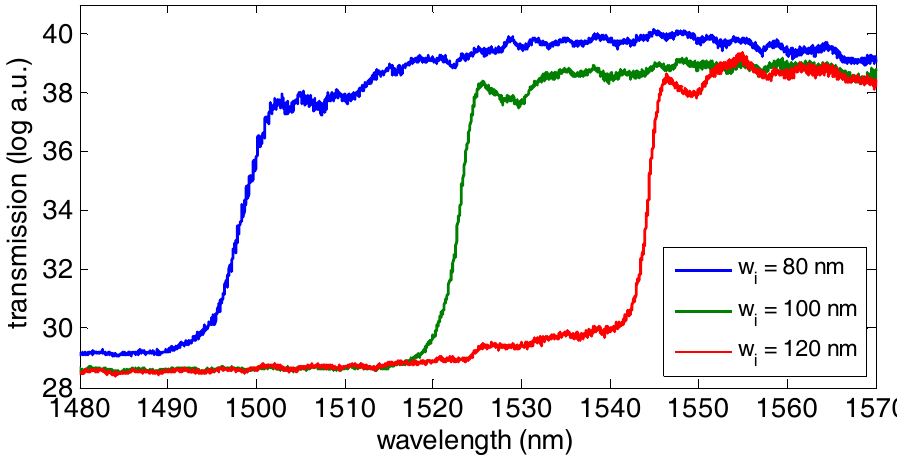
Figure 10. Initial spectrum in phosphate buffered saline (PBS) 1× for the PBG sensing structures within one sensor group (transmission units are given by the analog-to-digital converter (ADC) values provided by the IR camera). Note that the spectrum for the PBG sensing structure with w i = 140 nm is not depicted because its PBG edge is above the measurement wavelength range.